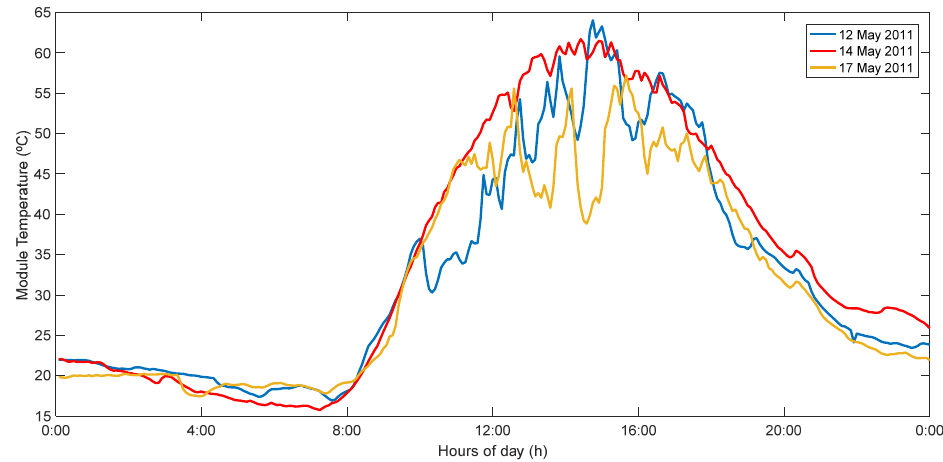
Figure 17. Daily profiles of temperature losses in PV module obtained during 12, 14 and 17 May 2011. As the temperature decreases at these time instants, due to the presence of cloud shading, the response in the I-V curve of the module results in an increase in the voltage